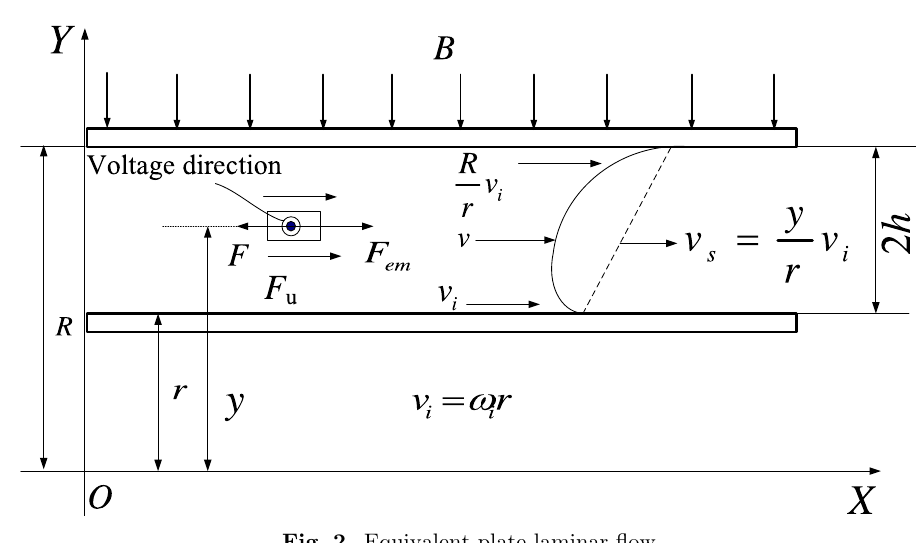
Fig. 2. Equivalent plate laminar fl